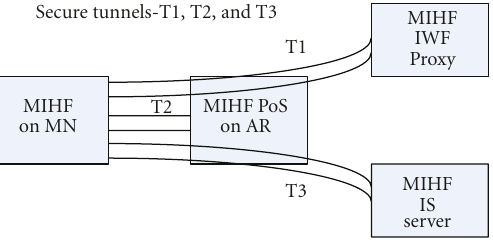
Figure 7: MIH message security through end-to-end